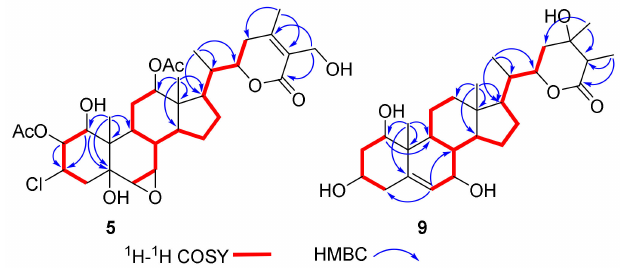
Figure 5. Key 1 H- 1 H COSY and HMBC correlations for compounds 5 and 9